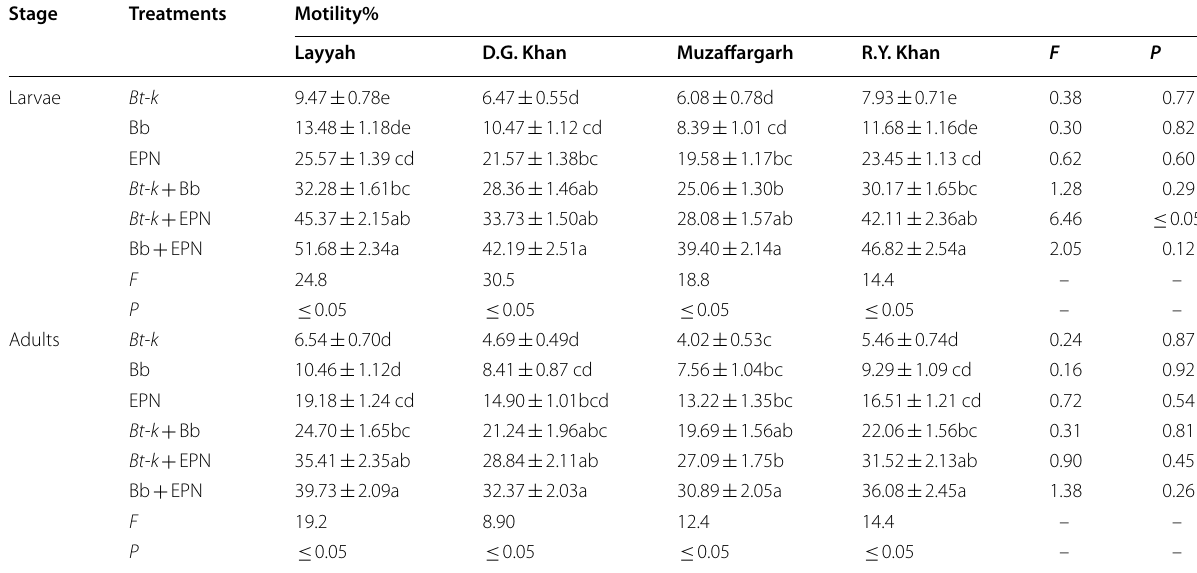
Mortality% followed by the same letter within each treatment and insect populations are not significantly different; HSD test P kurstaki , Bb: Beauveria bassiana , EPN: Heterorhabditis bacteriophora